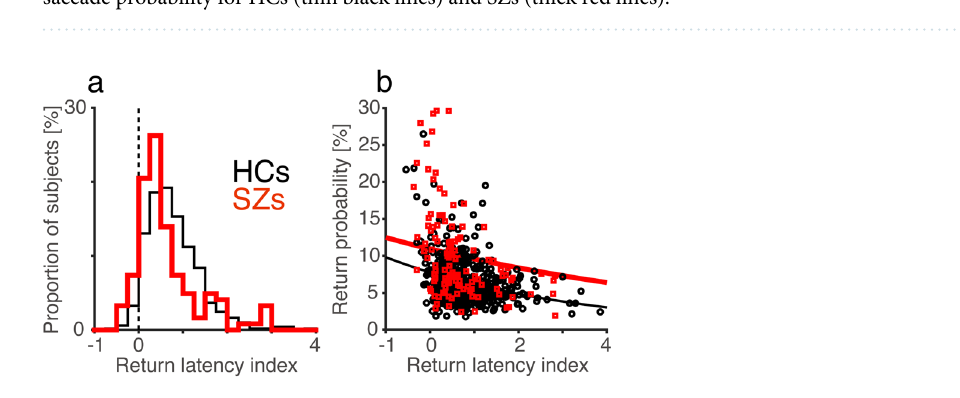
Figure 4. Relationship between return saccade probability and return latency index. ( a ) Frequency histograms of the return latency index for HCs (N = 490, thin black line) and SZs (N = 122, thick red line). ( b ) The relationship between the return saccade probability and return latency index for HCs and SZs. GLM analysis showed significant effects of the return latency index (coefficient = − 0.23 ± 0.03, t = − 6.8, p < 0.001) and group (coefficient = 0.34 ± 0.06, t = 5.4, p < 0.001), but not of the interaction (coefficient = 0.10 ± 0.06, t = 1.7, p = 0.09). Thin black and thick red lines represent regression lines estimated by the GLM model for HCs and SZs,